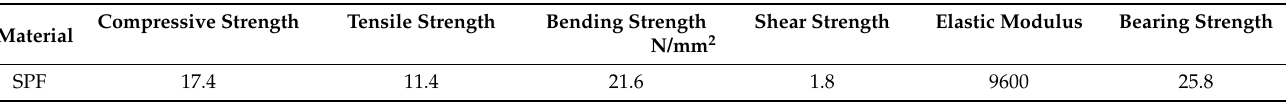
Table 3. Standard material properties of SPF lumber.